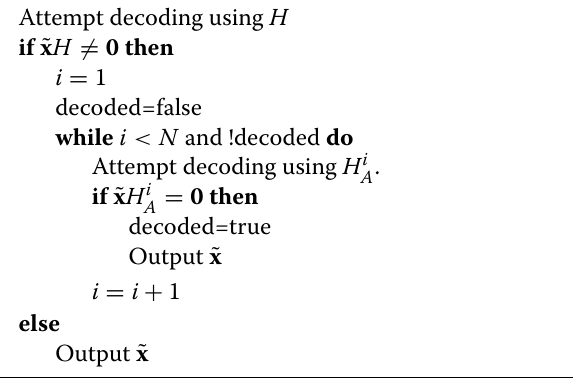
Algorithm 1 Operation of an augmented decoder. Attempt decoding using